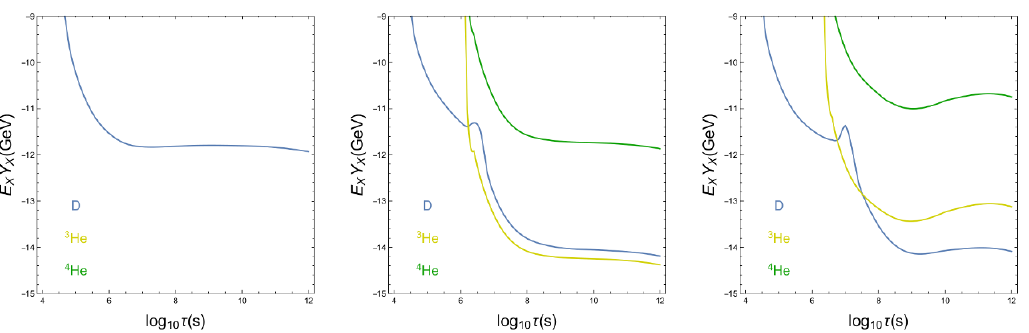
Figure 4 . Limits on E X Y X from BBN on the monochromatic photon decay of species X as a function of the lifetime (cid:28) X for photon injection energies E X = 10 MeV (left), 30 MeV (middle), and 100 MeV (right). Bounds are given for the e(cid:11)ects on the nuclear species D, 3 He, and 4